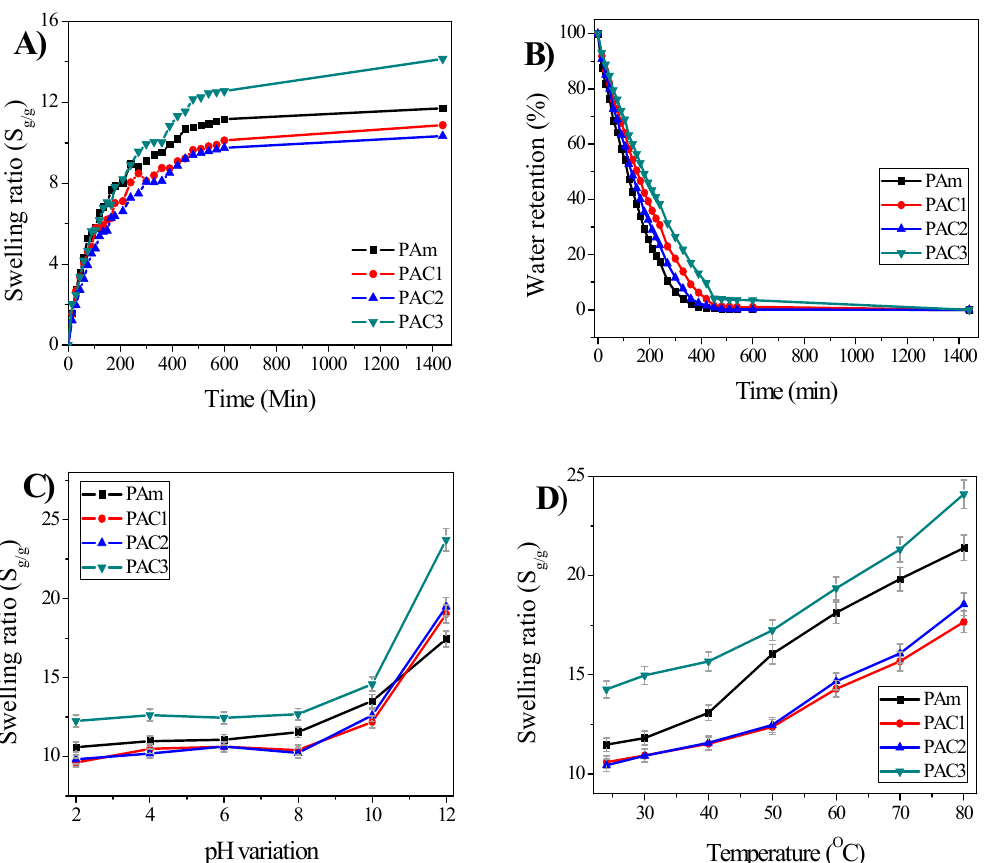
Figure 8. ( A ) Swelling ratio studies in de-ionized (DI) water, ( B ) water retention studies of PAm and PAC hydrogels, ( C ) swelling ratio at different pHs (2–12), and ( D ) temperature effect of swelling ratio in DI water.